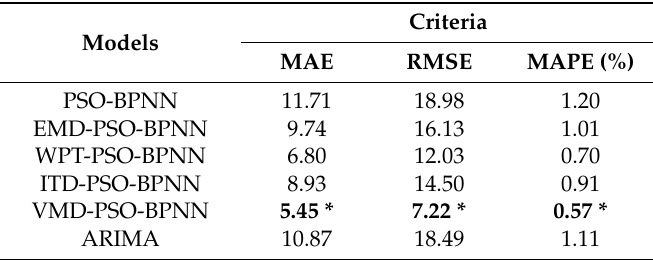
Table 5. Forecasting performance evaluation of